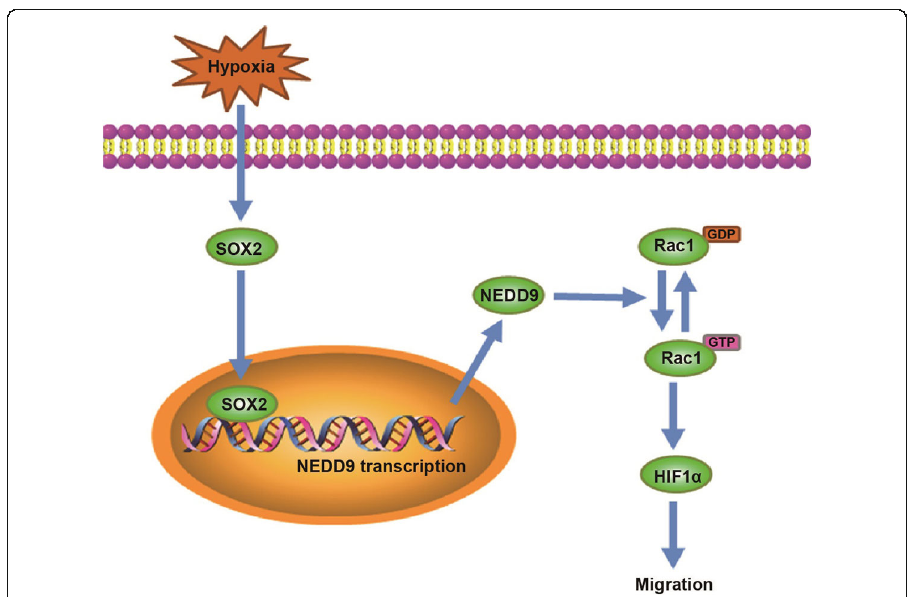
Fig. 6 Illustration of the mechanism of SOX2 promotion of breast cancer cell migration. SOX2 potentiates breast cancer cell migration under hypoxia by supporting NEDD9 expression and leading to the activation of NEDD9 downstream effector HIF-1 α signaling pathway. NEDD9 maintains HIF-1 α protein stability under hypoxia, at least in part, in a Rac1-dependent